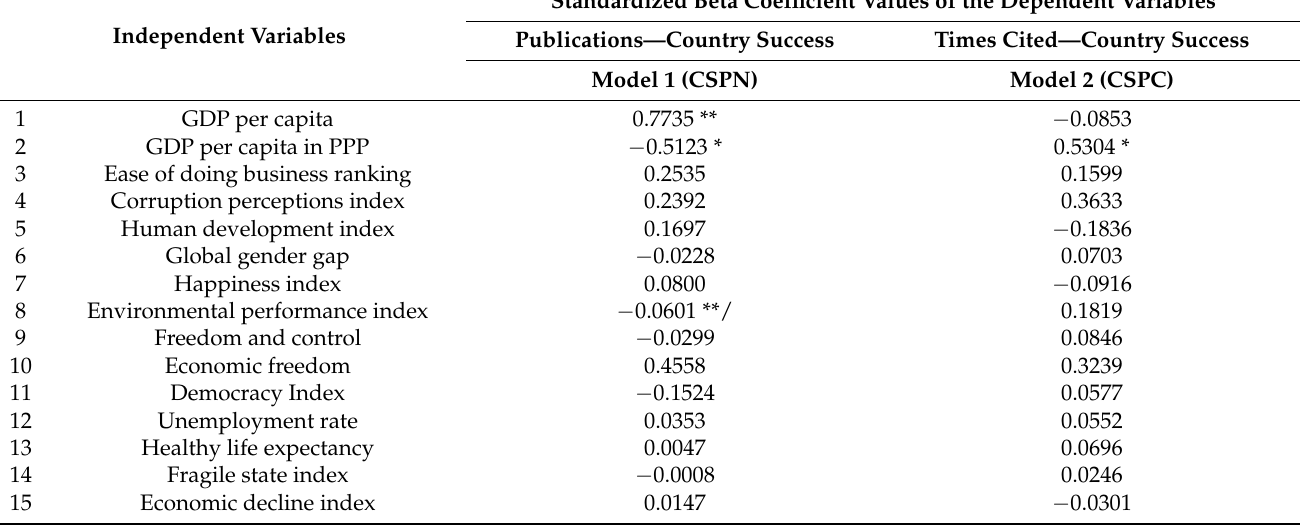
Table 7. Standardized beta coefficient values of the dependent